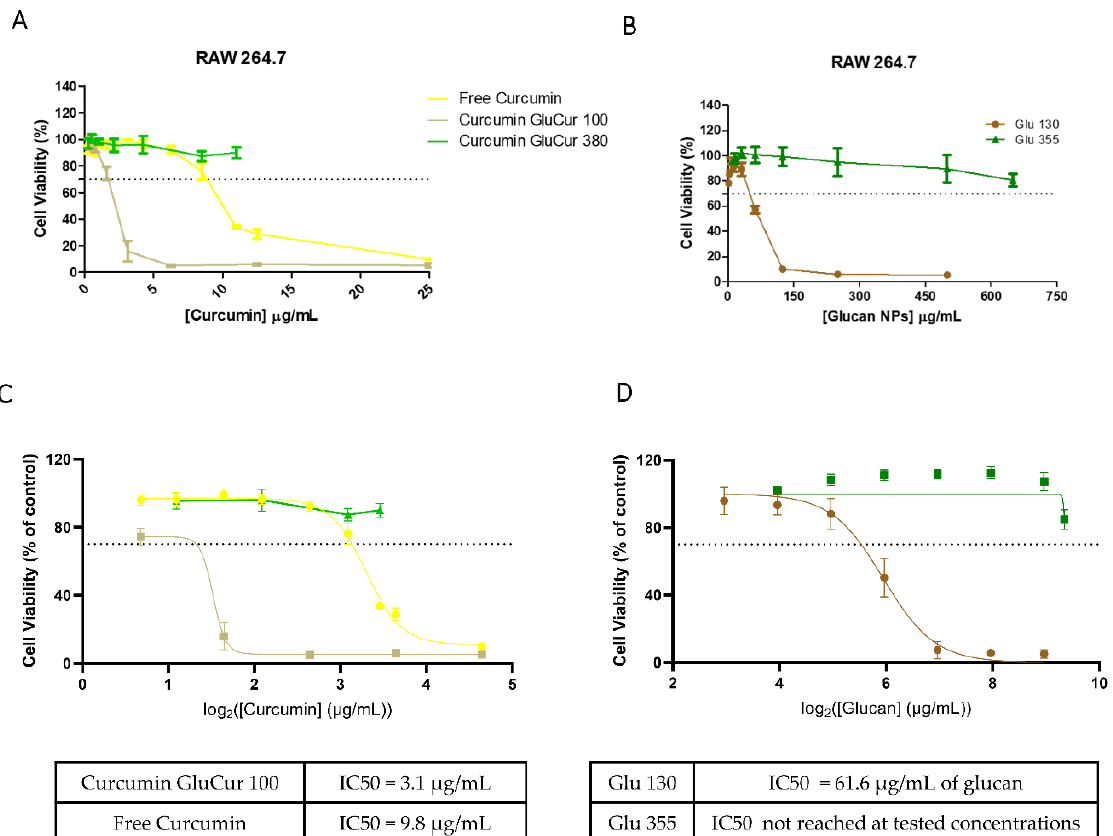
Figure 6. Cytotoxicity effect of the curcumin-loaded glucan NPs and free curcumin on murine RAW 264.7 cells. Cell viability was evaluated with the MTT assay after an incubation period of 24 h with increasing concentrations of free drug, GluCur 100, GluCur 380 NPs ( A ), and the unloaded-curcumin NPs ( B ). Nonlinear regression analysis of the cell viability data, allowing the extrapolation of IC50 values for GluCur 100 and free curcumin ( C ) and for the nanoparticles without curcumin, Glu 130, and Glu 355 ( D ) (mean ± SEM, n = 5, five independent experiments, each in triplicate).